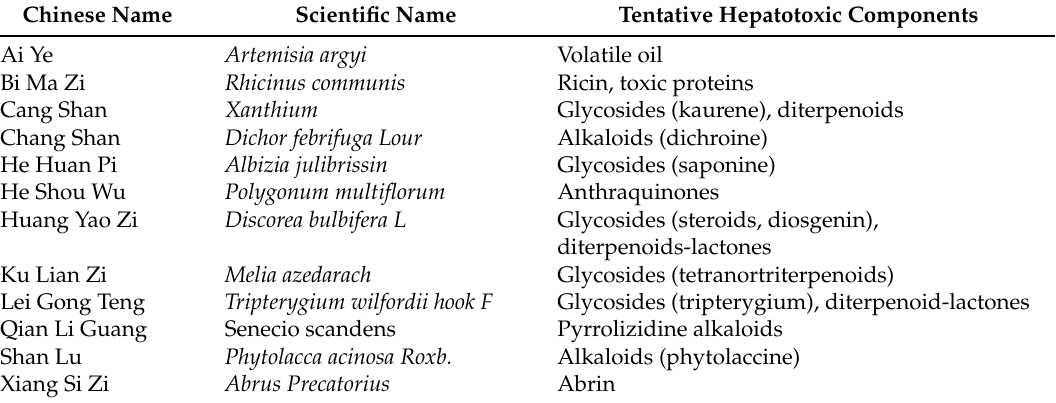
Table 2. Some examples of suspected toxic compounds as suggested causes of hepatotoxicity by herbal Traditional Chinese Medicine